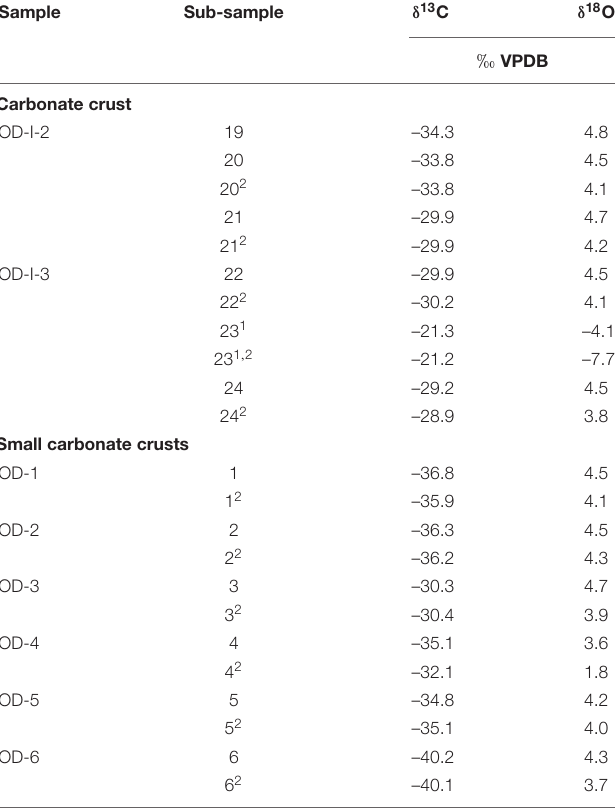
TABLE 5 | Stable carbon and oxygen isotope composition of the crusts. TABLE 6 | Content of organic and inorganic carbon calculated as CaCO 3 and stable carbon isotope composition of carbonate